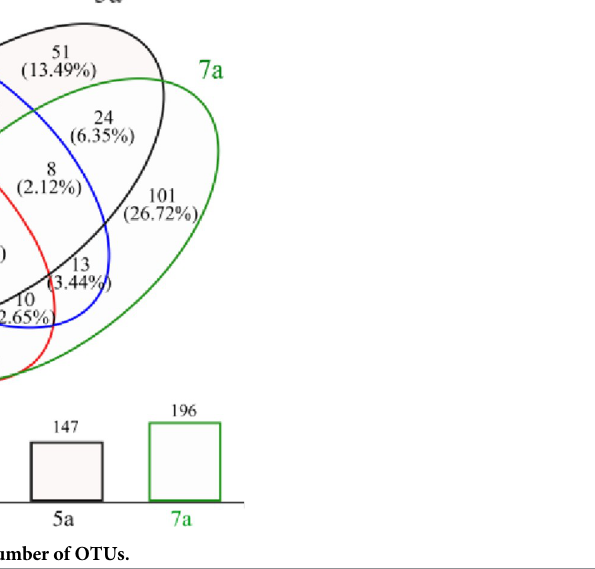
Fig 6. Venn diagram showing the number of